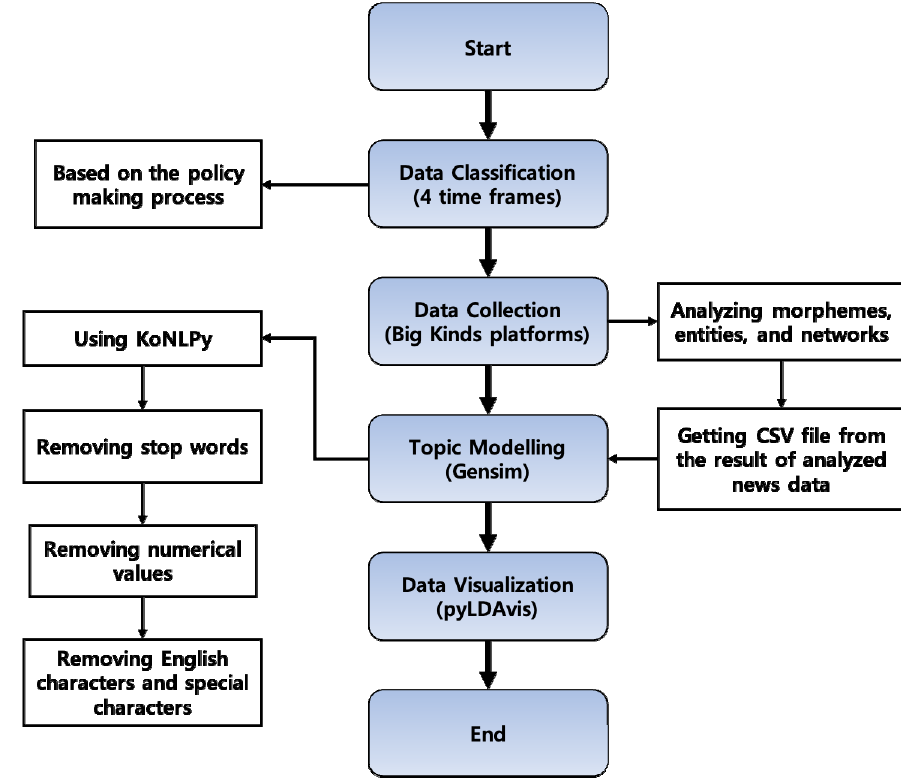
Figure 2. The study procedure for big data analysis on COVID-19 vaccination.